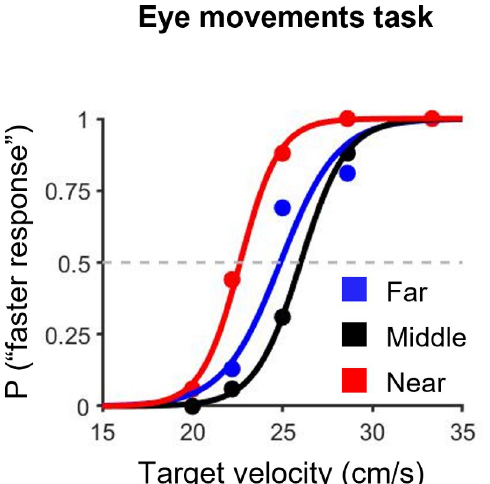
Fig 8. Typical examples of psychometric functions for the eye movements tasks. The blue, black and red lines indicate the far, middle and near conditions, respectively.